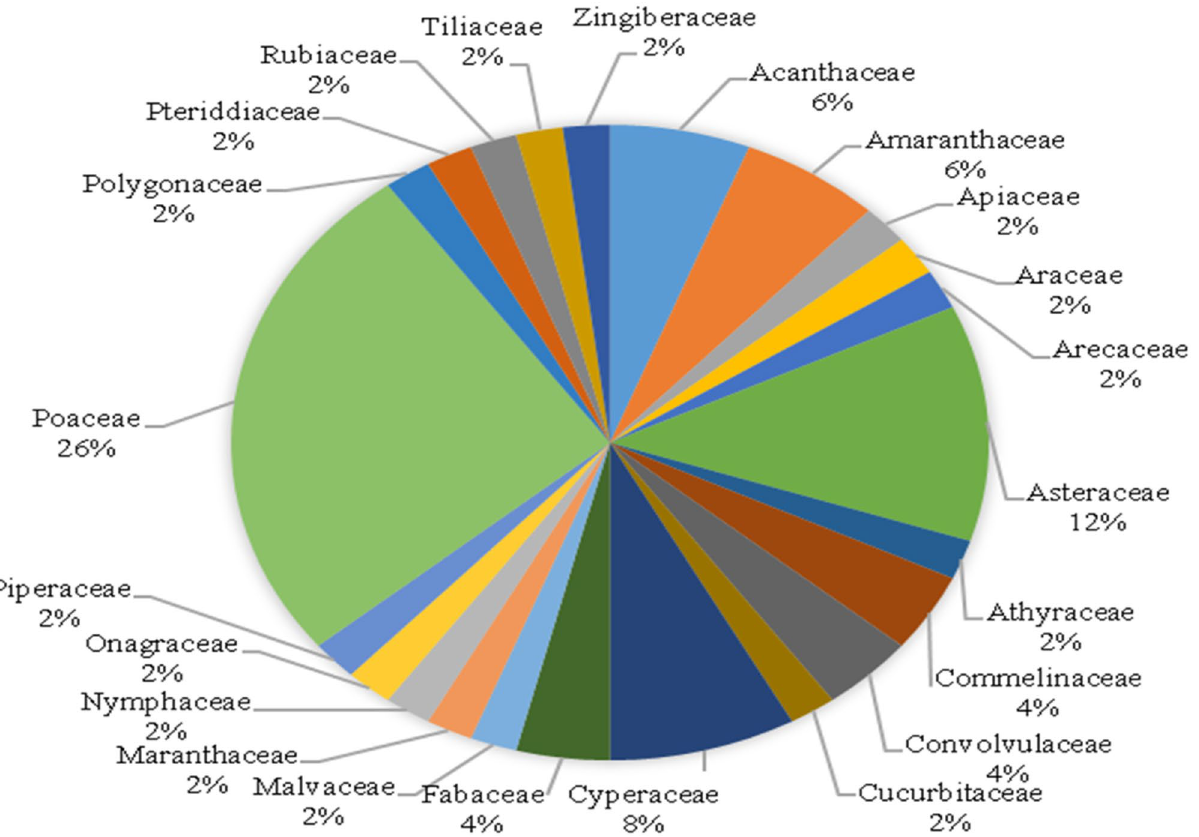
Figure 4. Percent distribution of riverine wetland flora families in Bamenda